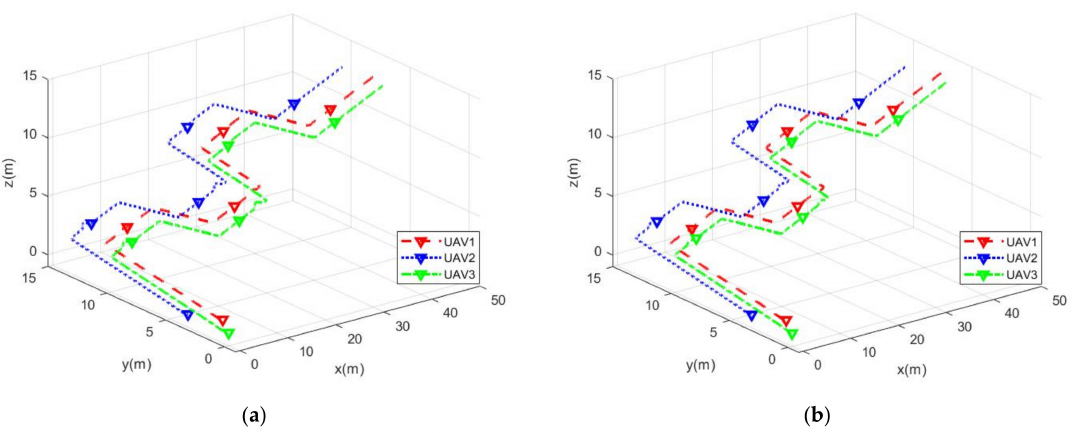
Figure 11. Trajectory tracking for UAVs with RMPC ( a ) and IMPC ( b ) in Case 2. Both IMPC and RMPC can accomplish trajectory